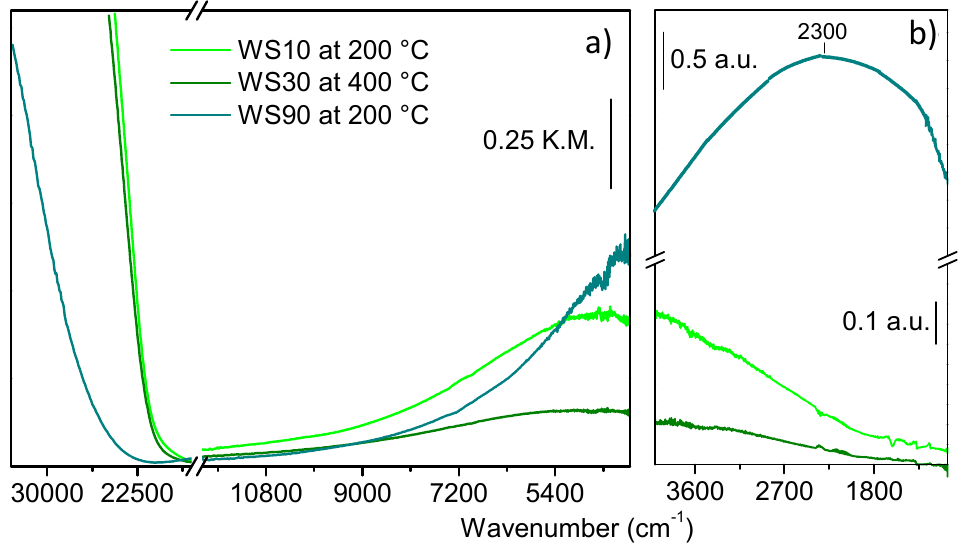
Figure 4. UV–Vis–NIR ( a ) and medium IR ( b ) spectra of WS10, WS30, and WS90 during interaction with CO/O 2 (1:5, p CO = 5 mbar) mixture at the temperature of the maximum intensity reached by the main electronic absorption.